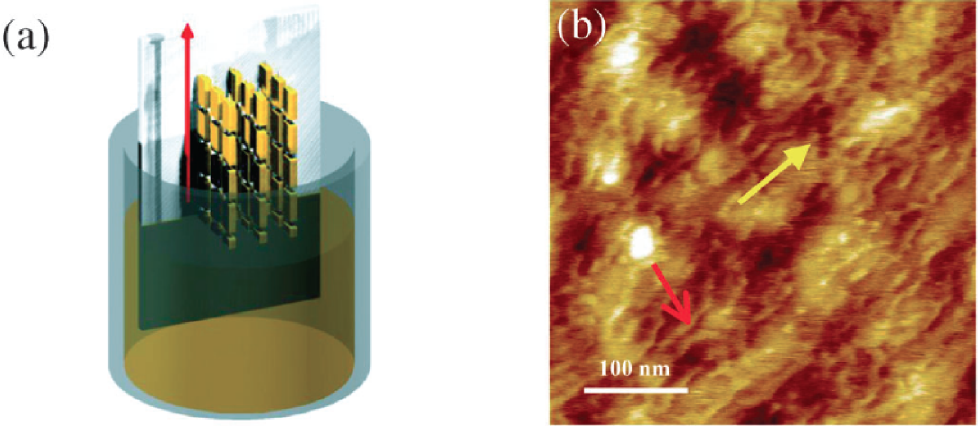
Figure 8. ( a ) Graphical depiction of the CDT-BTZ deposition by dip-coating showing the polymer backbones aligned parallel to the dipping direction; ( b ) AFM image showing the polymeric fibres (red arrow) aligned along the dipping direction (yellow arrow) (Reprinted with permission from reference [78]. Copyright (2012) by Wiley-VCH Verlag GmbH &